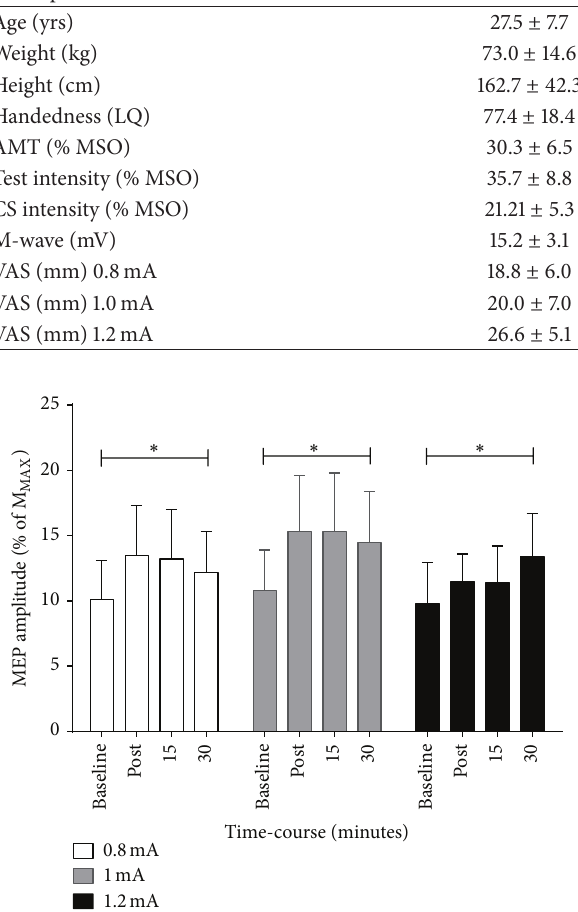
Figure 1: Mean ± SE motor-evoked potential amplitude (expressed ) evoked in the ECRL muscle during as a percentage of 𝑀 MAX baseline, immediately after, 15 and 30 minutes and for 0.8 mA (Left), 1.0mA (middle) and 1.2mA (right). Post hoc analyses showed that MEP amplitudes were facilitated immediately after and 15 and 30 minutes following anodal tDCS ( 𝑃 < 0.001 ); however there were no differences between current intensities ( 𝑃 > 0.05 ). ∗ 𝑃 < 0.05 compared to